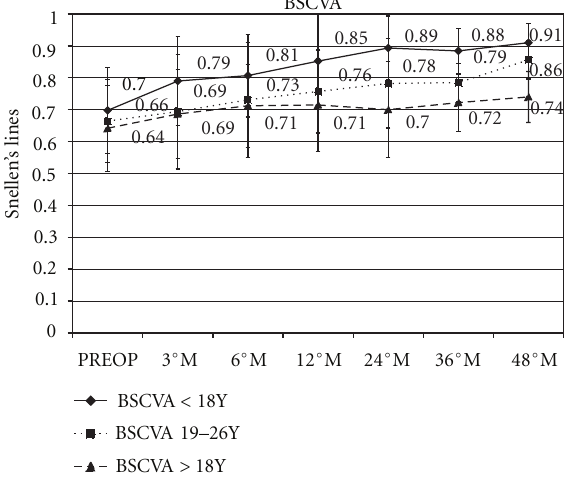
Figure 2: Graph showing visual performance during followup. After cross-linking, best spectacle-corrected visual acuity (BSCVA) in patients ≤ 18 years showed a mean gain of +0.15, +0.19, +0.18 and +0.21 Snellen lines at 12, 24, 36, and 48 months of followup, respectively; in patients between 19 and 26 years showed a mean gain of +0.10, + 0.12, +0.13, and +0.2 Snellen lines at 12, 24, 36, and 48 months followup, respectively; in patients ≥ 27 years showed a mean gain of +0.07, +0.06, +0.08, and +0.10 Snellen lines at 12, 24, 36 and 48 months of followup, respectively.